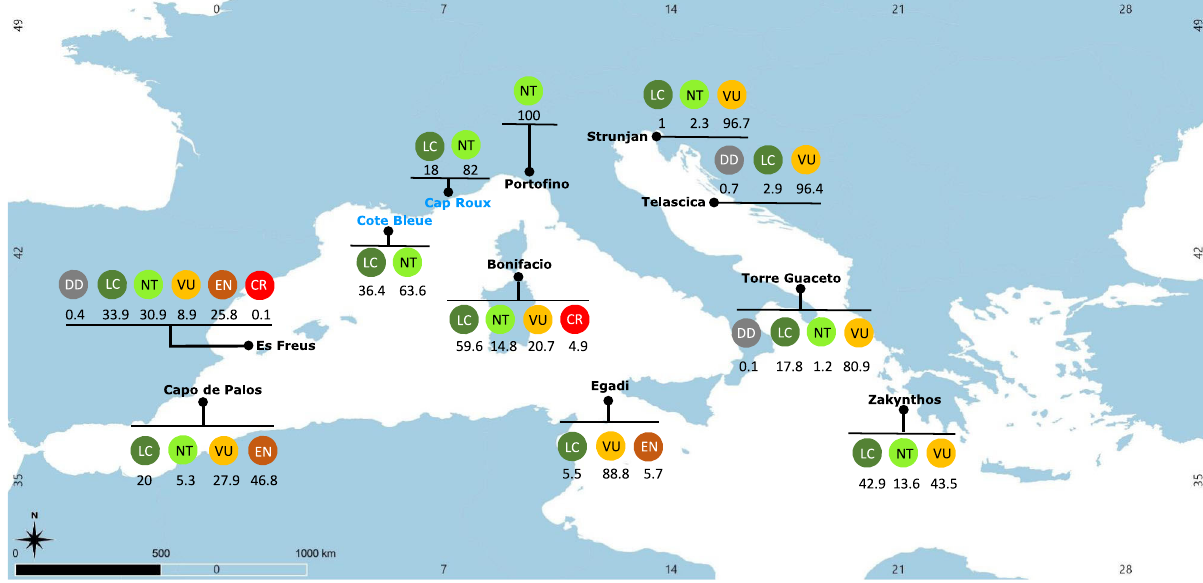
Fig.1|Studylocations. NumbersreportthepercentageofelasmobranchsbyIUCN categories caught (i.e., Biomass CPUE data) at each location. Names in black indi- cate locations where a multiple-use MPA is present and where catches were mon- itored both within the partially protected areas (PPAs) and in nearby unprotected